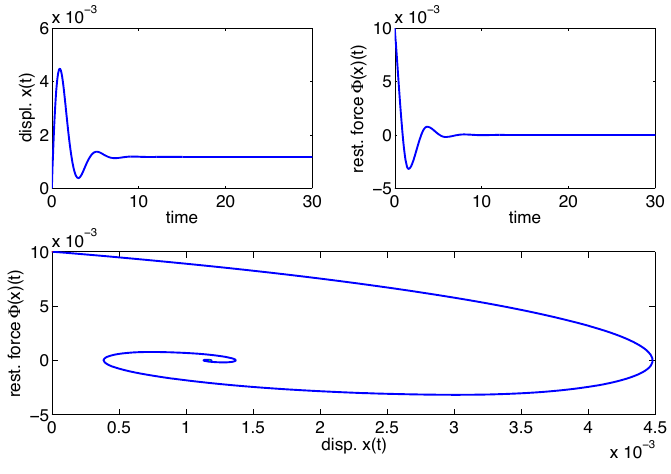
Figure 2. Limit cycle absence in Class I